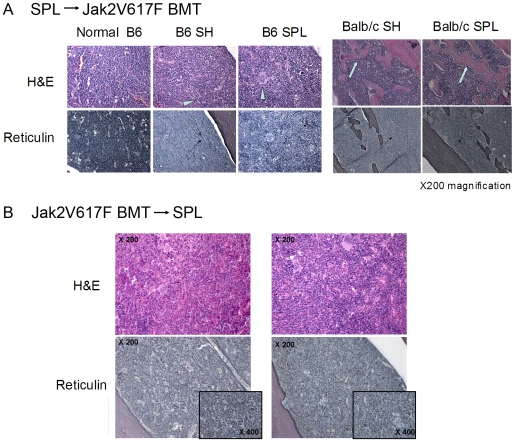
Pathologic fibrosis and osteosclerosis are equivalent in polycythemic and splenectomized, normocythemic mice.A. In the SPL→BMT experiment, histology was performed on tissues from mice approximately 9–10 weeks after SH or SPL. Bone marrow histology shows increased cellularity, prominent megakaryocytes (arrowheads) and reticulin fibrosis (thin arrows in lower panels) in both SH and SPL groups of mice compared to age-matched normal bone marrow. In Balb/c mice, extensive new bone formation (osteosclerosis, aqua arrows) and reticulin fibrosis are found equally in both SH and SPL mice 6 weeks after transplant. B. Splenectomy after V617F-driven PV occurs results in similar hypercellularity (top H & E staining) and reticulin fibrosis in SH and SPL operated mice.